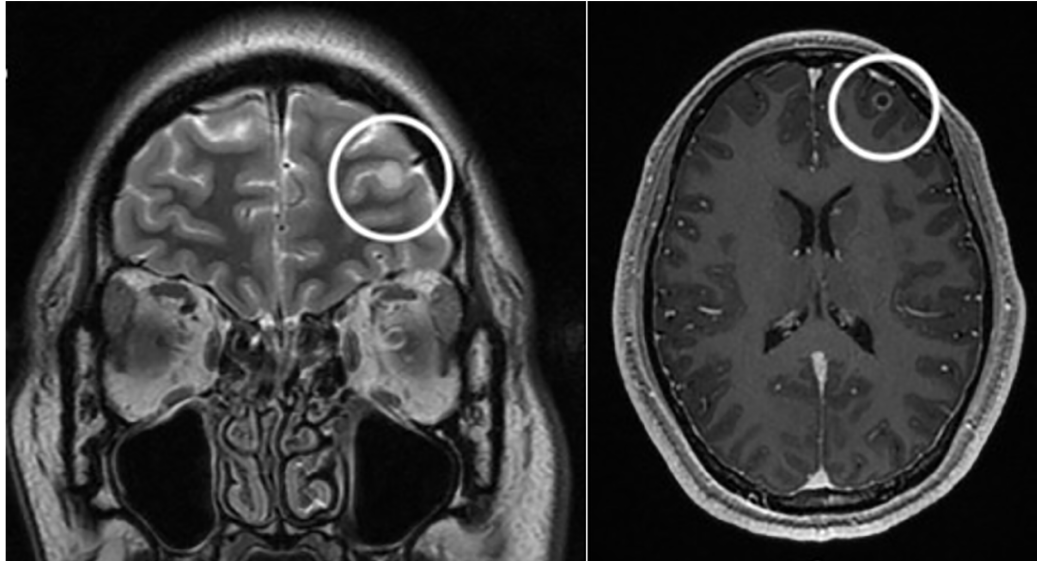
Image 3. Magnetic resonance imaging showing ring enhancing lesion (circles) in the left anterior frontal lobe; coronal view at left and axial at